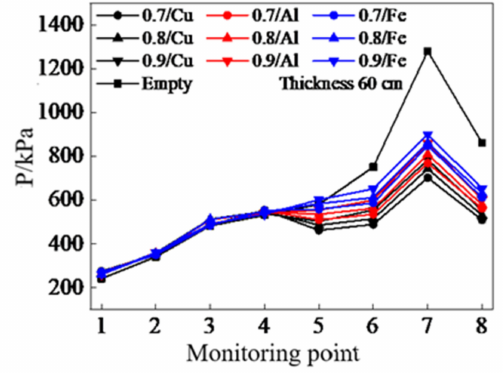
Figure 22. Maximum overpressure at each monitoring